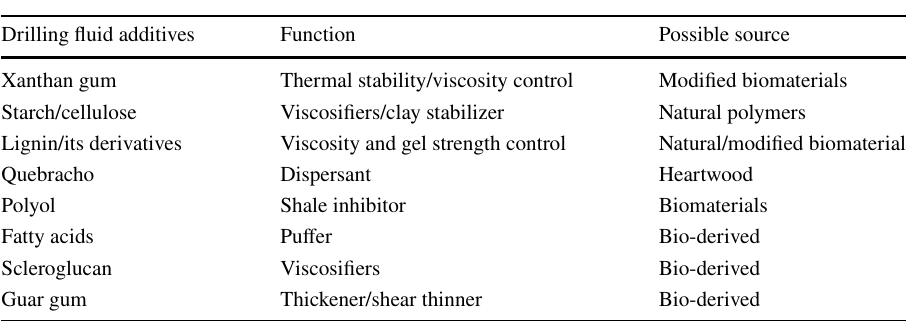
Table 1 Renewable materials for drilling fluid